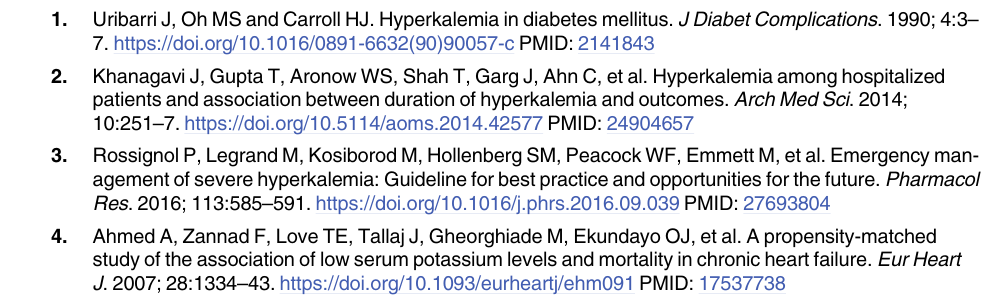
S1 Table. Multinomial logistic regression for the factors associated with dyskalemia. eGFR, estimated glomerular filtration rate based on the CKD-EPI formula; Hb, hemoglobin. All vari- ables with a p-value of less than 0.1 in Table 1 were introduced into the model. A backward selection process was conducted with 500x sampling bootstrap method. Variables were catego- rized to attain log-linearity. Hypokalemia defined as K + < 3.5 mmol/L (N = 148).